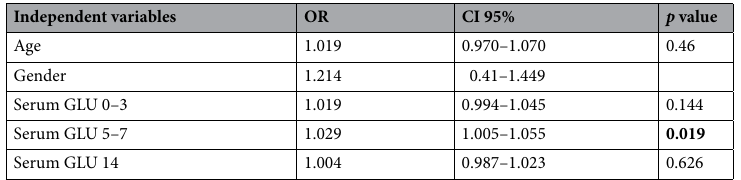
Table 4. Odds ratio (OR) of poor outcome at 3 months. Age, gender and serum glutamate levels as predictors. OR, odds ratio; CI, confidence interval; CSF, cerebrospinal fluid; GLU, glutamate. Significant values are in